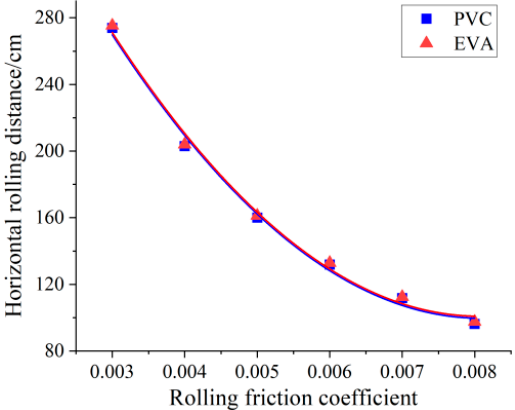
Figure 12. Fitting curve of rolling friction coefficient and rolling distance.